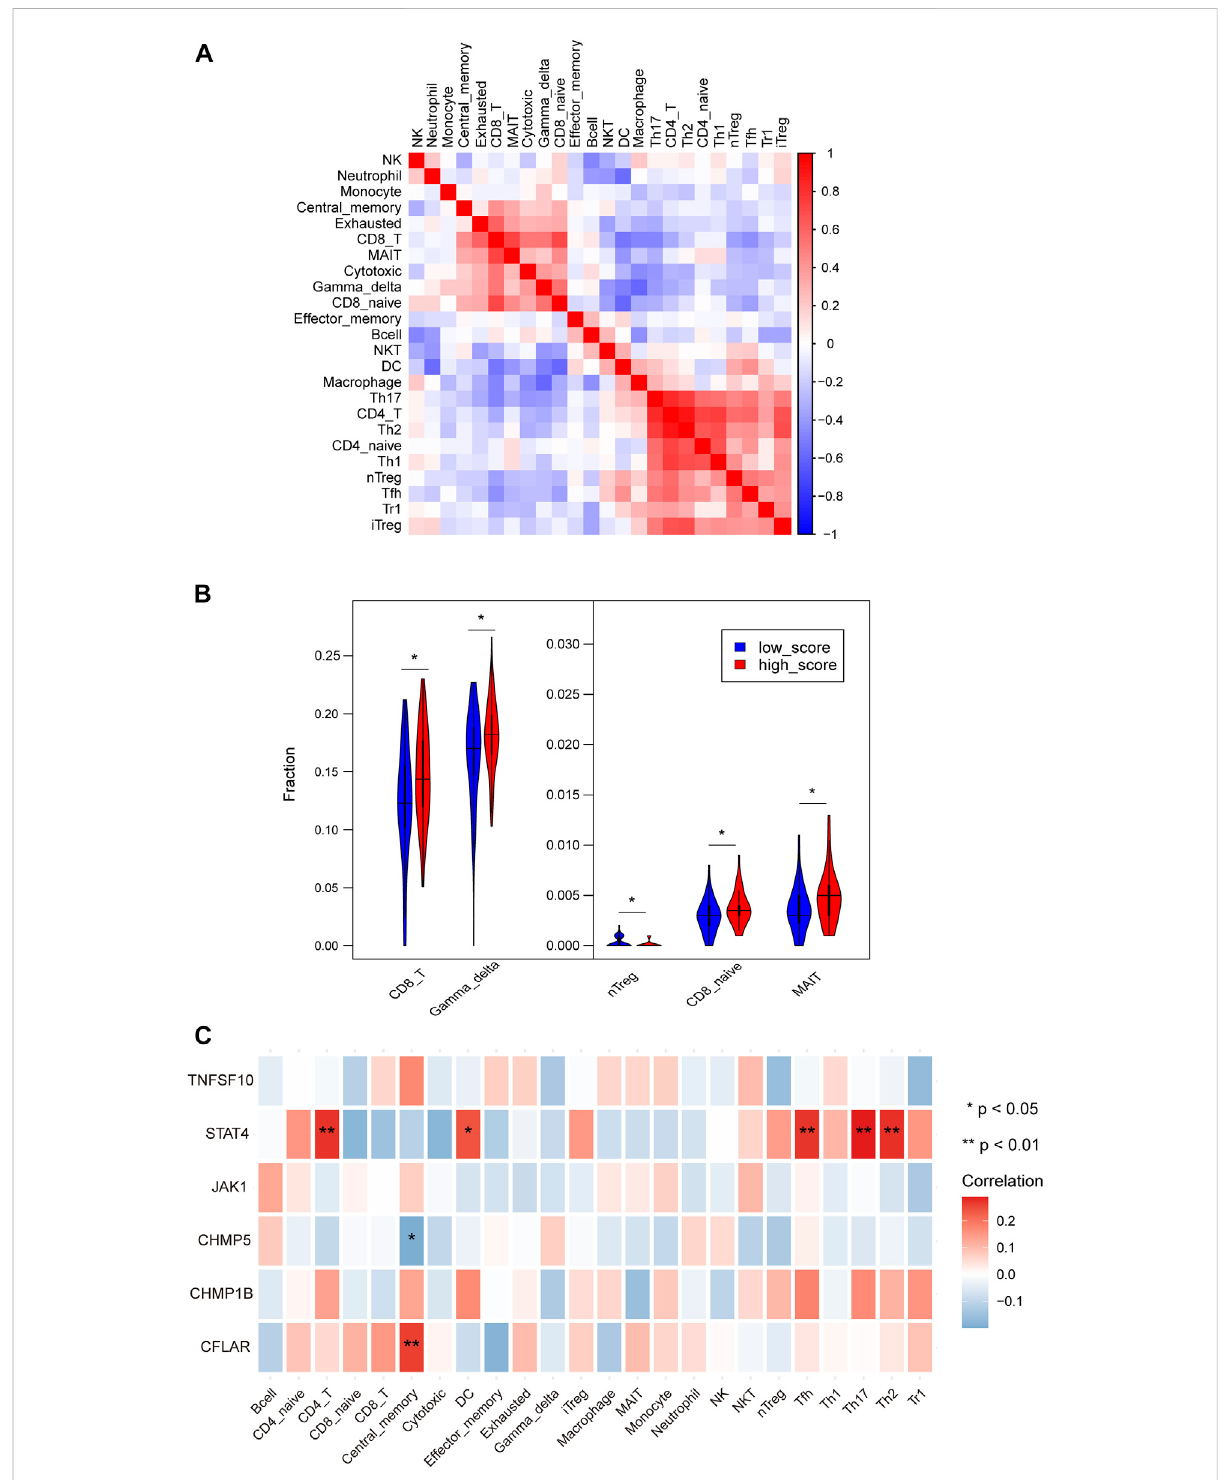
FIGURE 5 (A) Heatmaps depicting the correlations between distinct immune cell compositions. (B) The violin plot showed the statistically different immune in fi ltration score between the high-NRS and low-NRS groups in myocardium. (C) Correlation analysis of immune cell in fi ltrations with characteristic